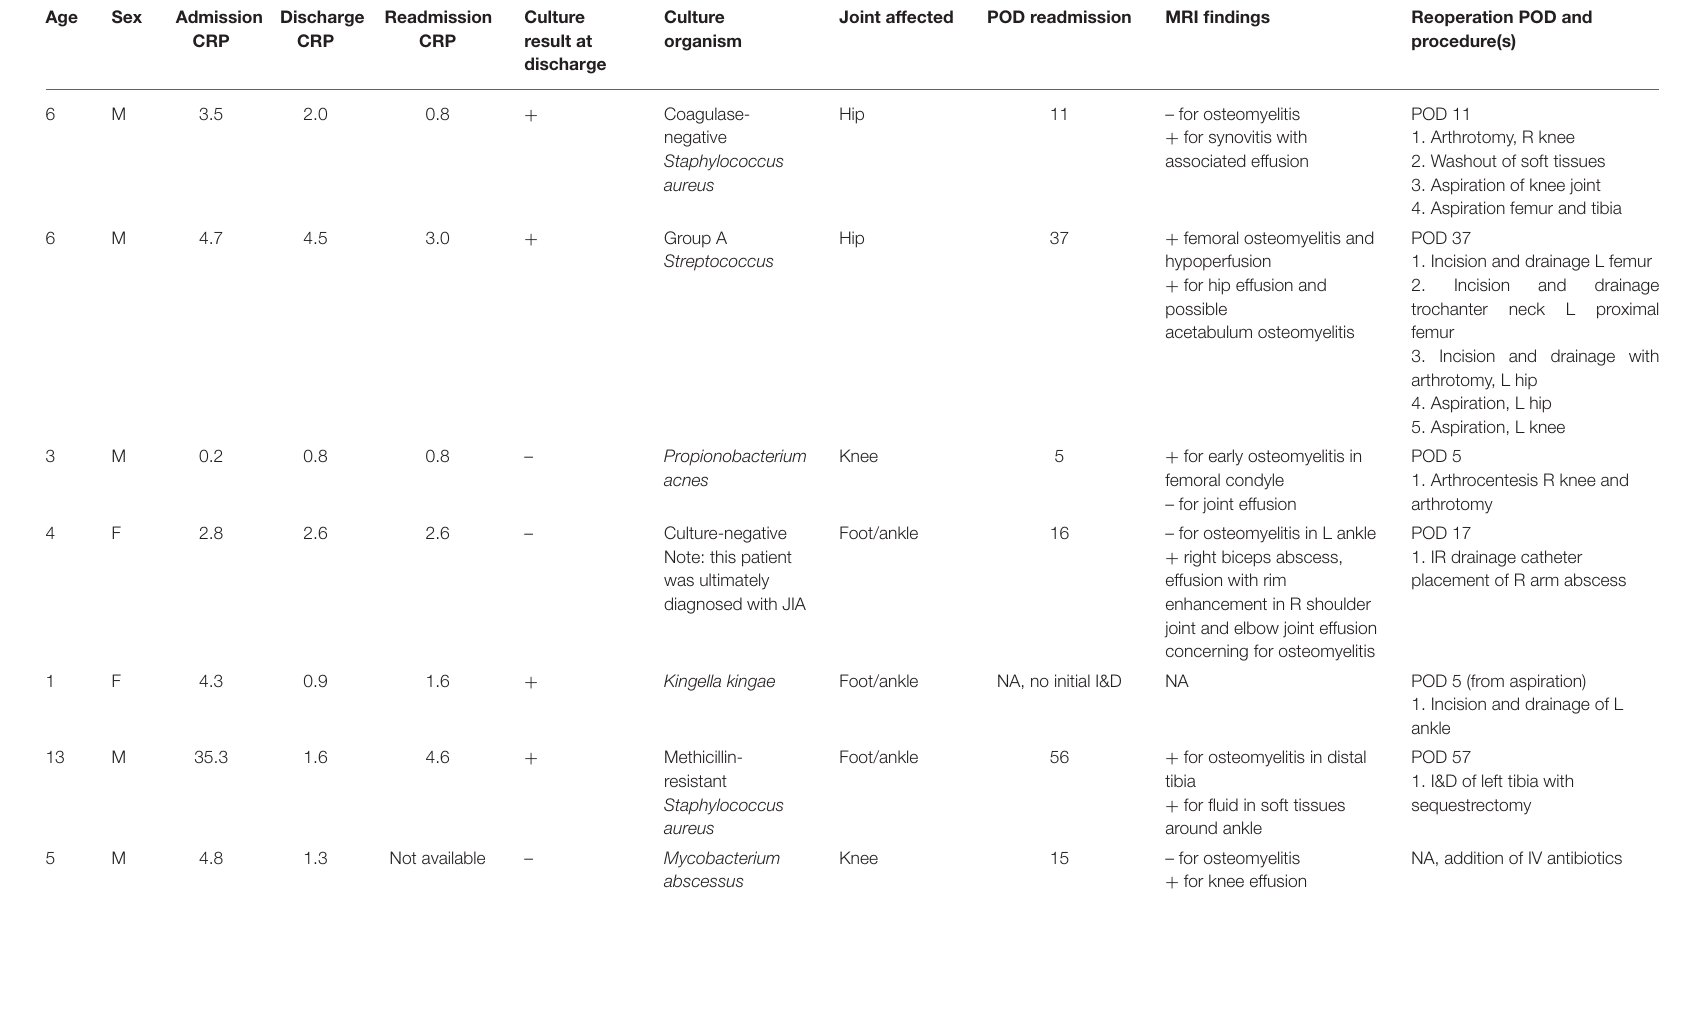
TABLE 3 | Patient factors, laboratory values, and imaging results of patients readmitted after initial discharge.